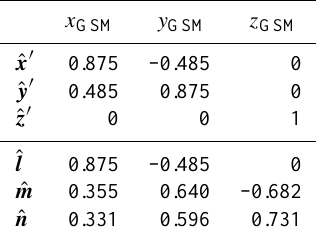
Table 3. The unit base vectors of the two specialised coordinate systems x 0 y 0 z 0 and lmn , given in GSM coordinates.